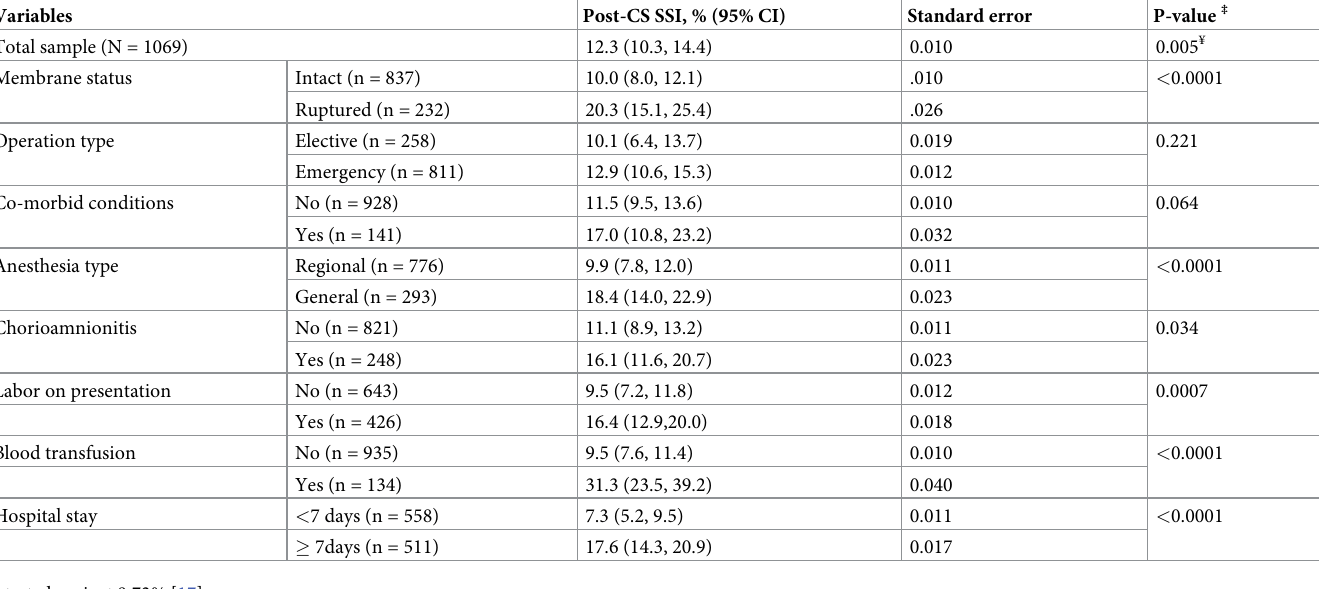
Table 3. Post-CS SSI by the characteristics present before or during cesarean section procedures in two public hospitals in Harar city, East Ethiopia.